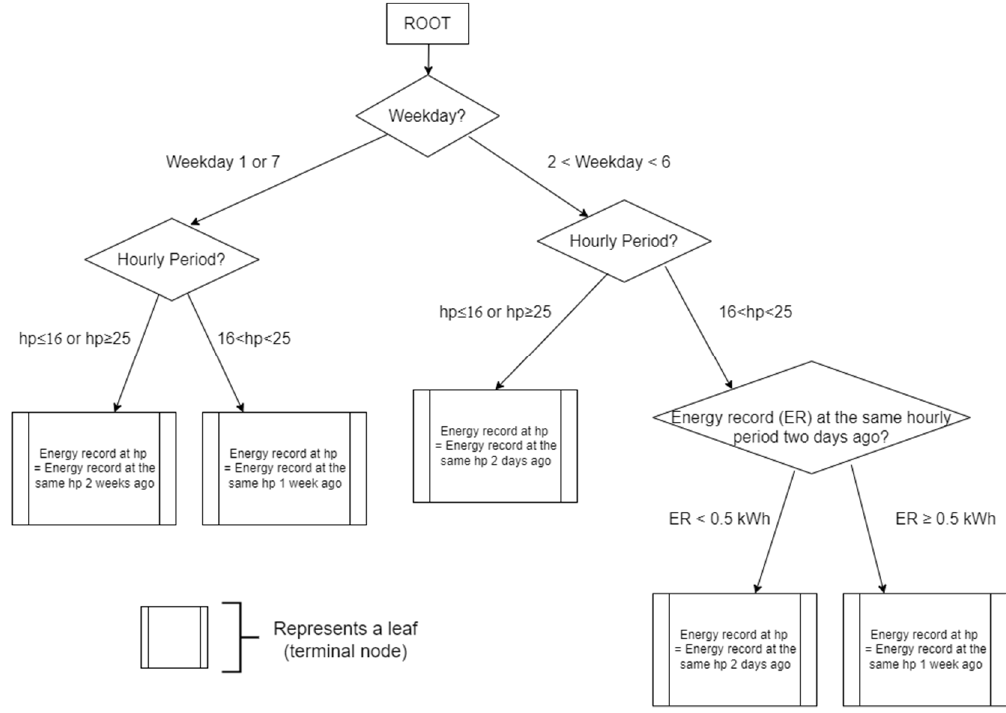
Figure 2. Example of a Random Forest Regressor model (just an example, not corresponding to any decision tree applied during the research).